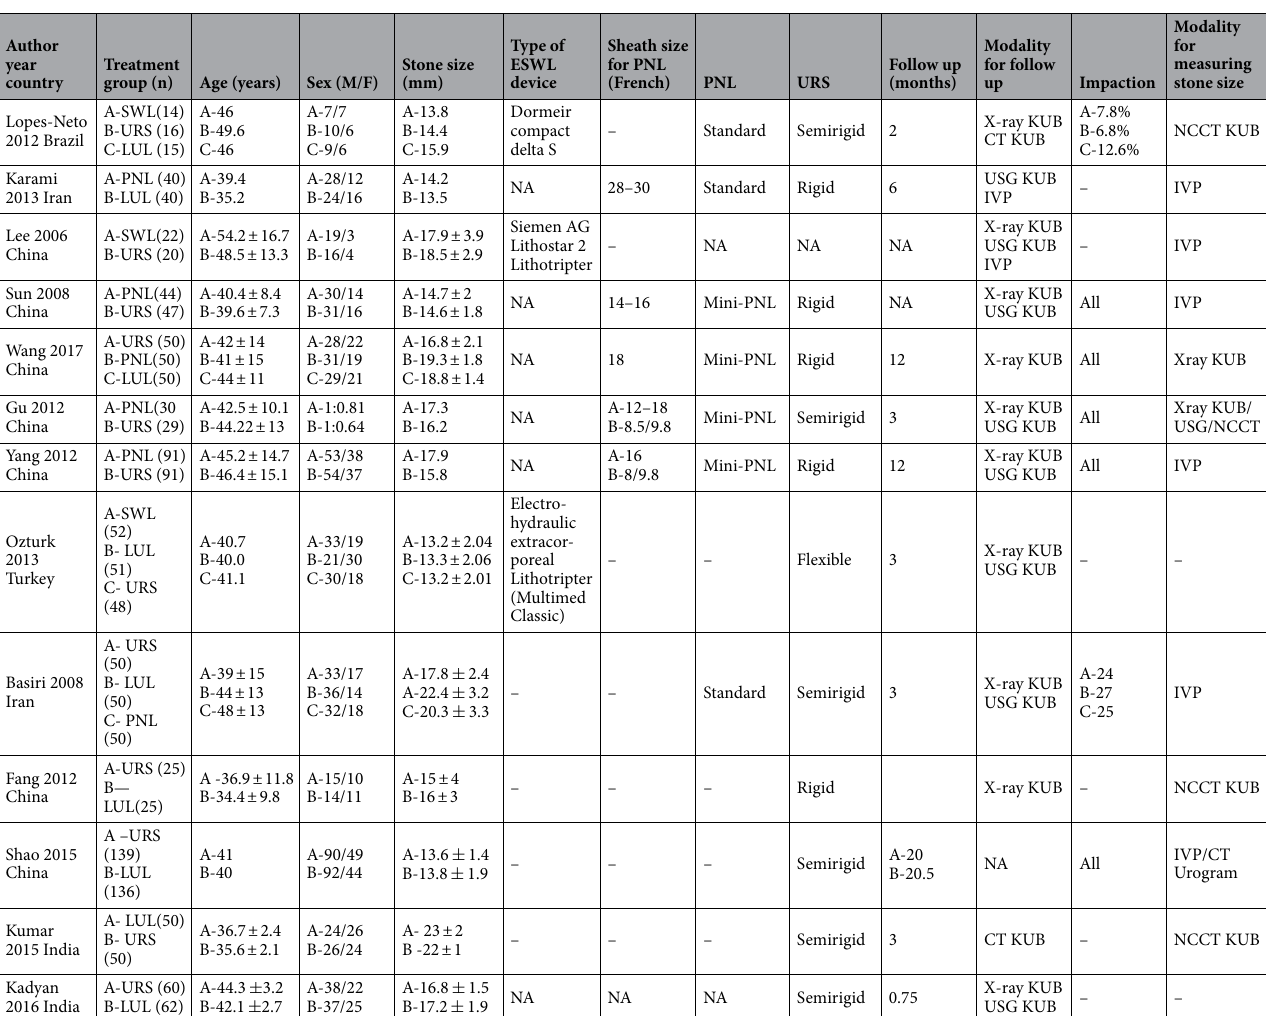
Table 1. Characteristics of the studies included in the overall analysis. PNL, Percutaneous Nephrolithotomy; URS, Uretero Renoscopic Lithotripsy; LUL, Laparoscopic Ureter lithotomy; SWL, Shock Wave Lithotripsy; KUB, Kidney Ureter Bladder; IVP, Intravenous Pyelography; CT, Computed Tomogram; USG, Ultra Sonography; NCCT, Non Contrast